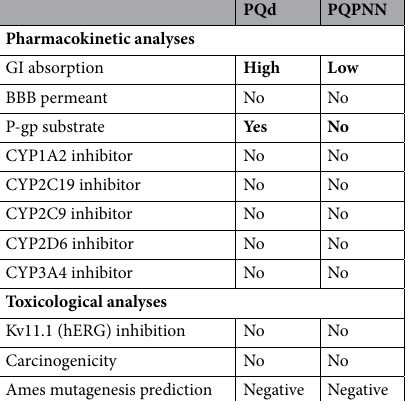
Table 2. Comparative pharmacokinetics and toxicological analyses of PQd and PQPNN. Pharmacokinetics analyses were performed with SwissADME and the toxicological analyses were performed with Pred-hERG and AdmetSAR